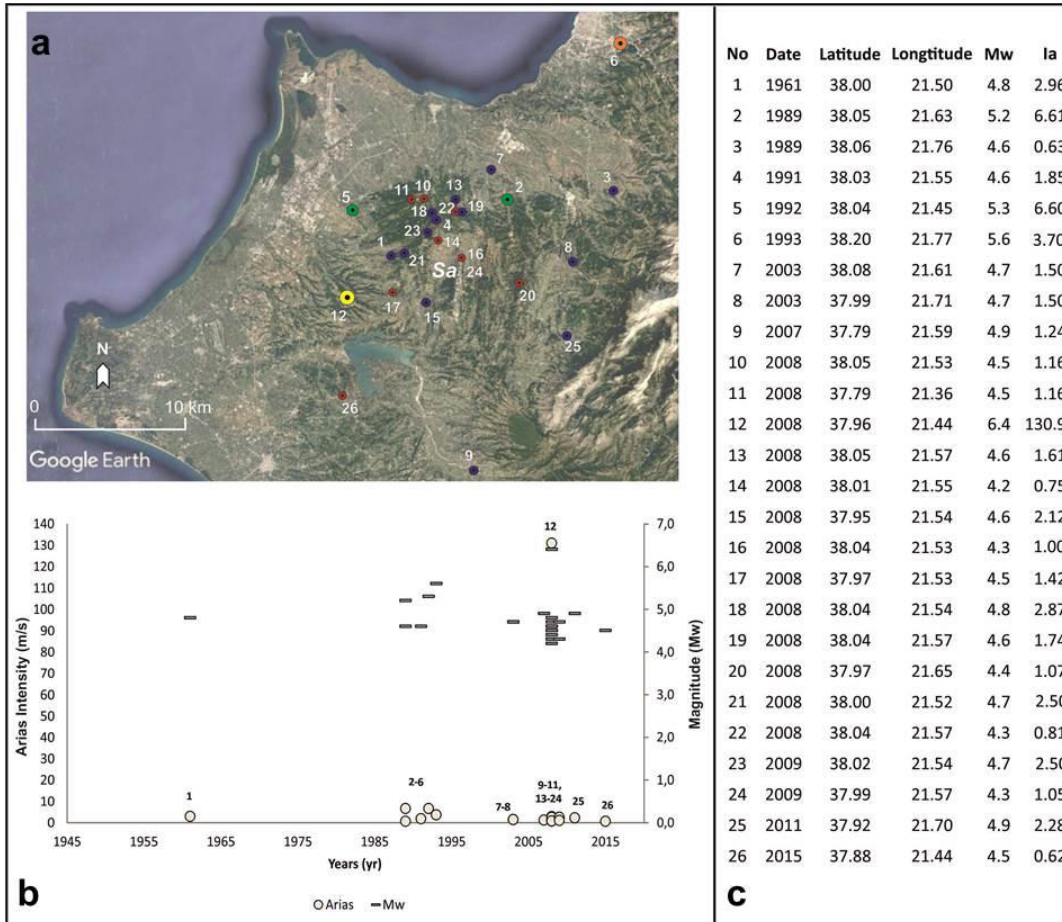
Figure 8. ( a ) Map of epicenter distribution in the Skolis Mtn area for the period. The map is extracted from Figure 4. 0 ≤ Mw ≤ 4.5 events, the blue show the epicenters of 4.6 ≤ Mw ≤ 5.0 events, the green show the epicenters of the 5.1 ≤ Mw ≤ 5.5 events, the orange shows the epicenters of 5.6 ≤ Mw ≤ 6.0 events, and the yellow dots show the epicenters of 6.1 ≤ Mw ≤ 6.5 events. The plotted events affected the landslide distribution and contributed to their evolution as deduced by the Arias intensity calculation. Sa : Santomerion village; ( b ) Diagram of Arias intensities, provided by Equation (1) and seismic magnitudes that affected Skolis area from 1945–2017. ( c ) The table presents the critical events that affected the studied area. The last years of 2016–2017 show no seismicity.